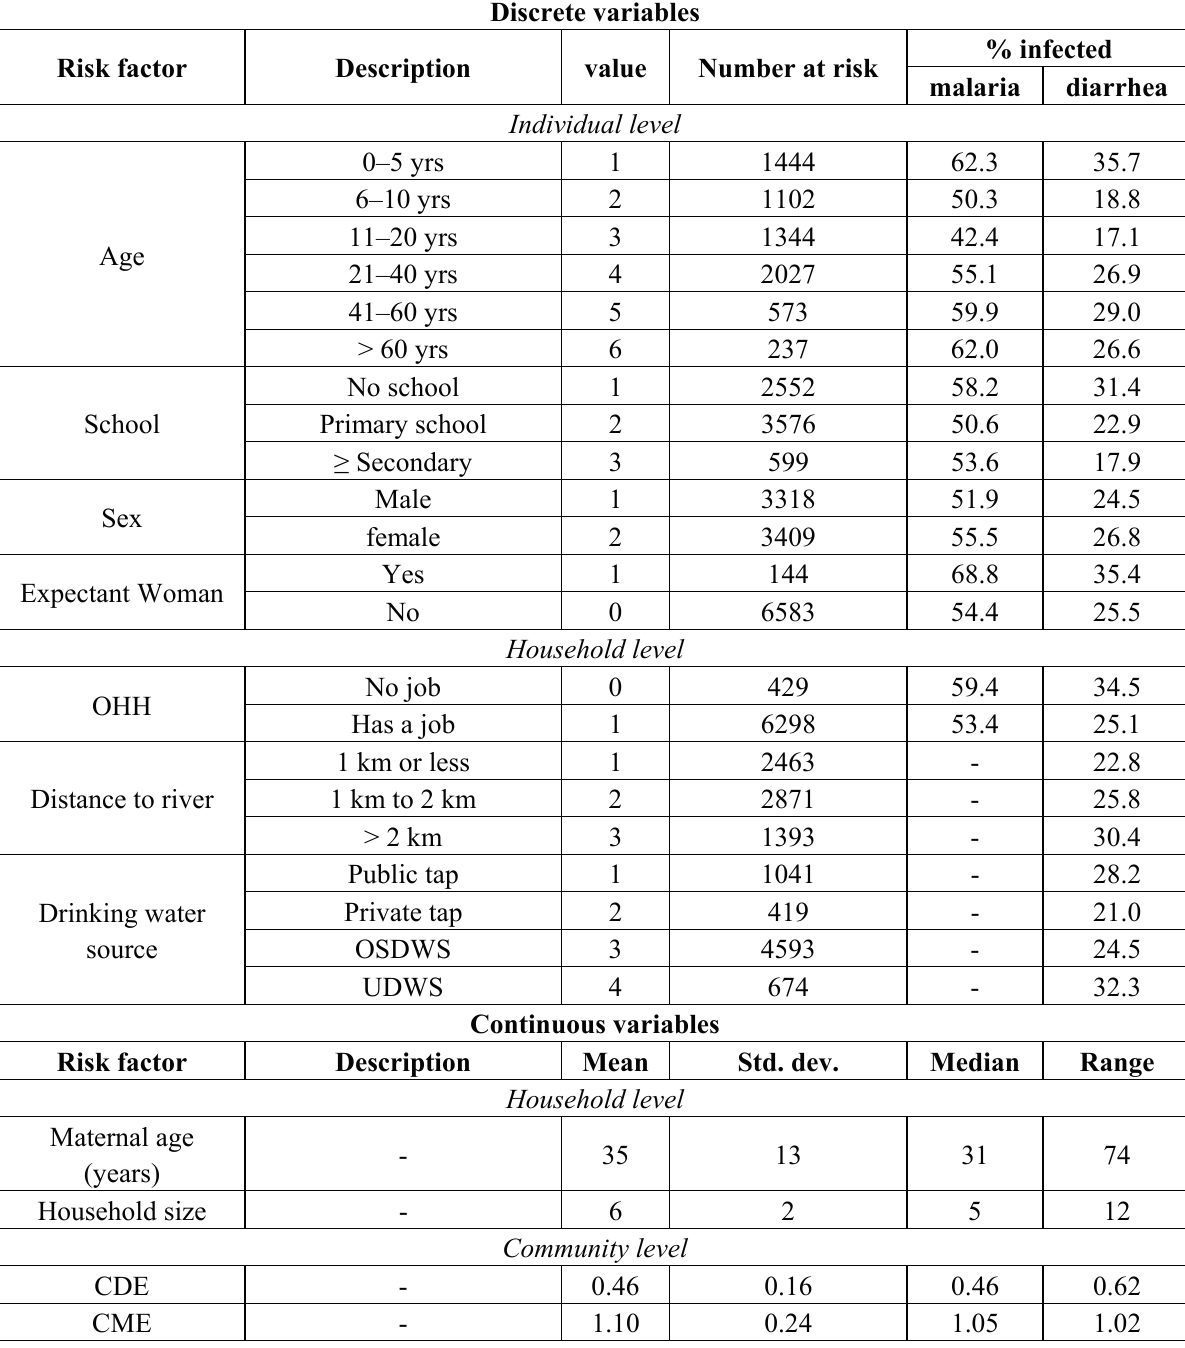
Table 1. Descriptive estimates of risk factors of malaria and diarrhea in Chikhwawa, Southern Malawi,